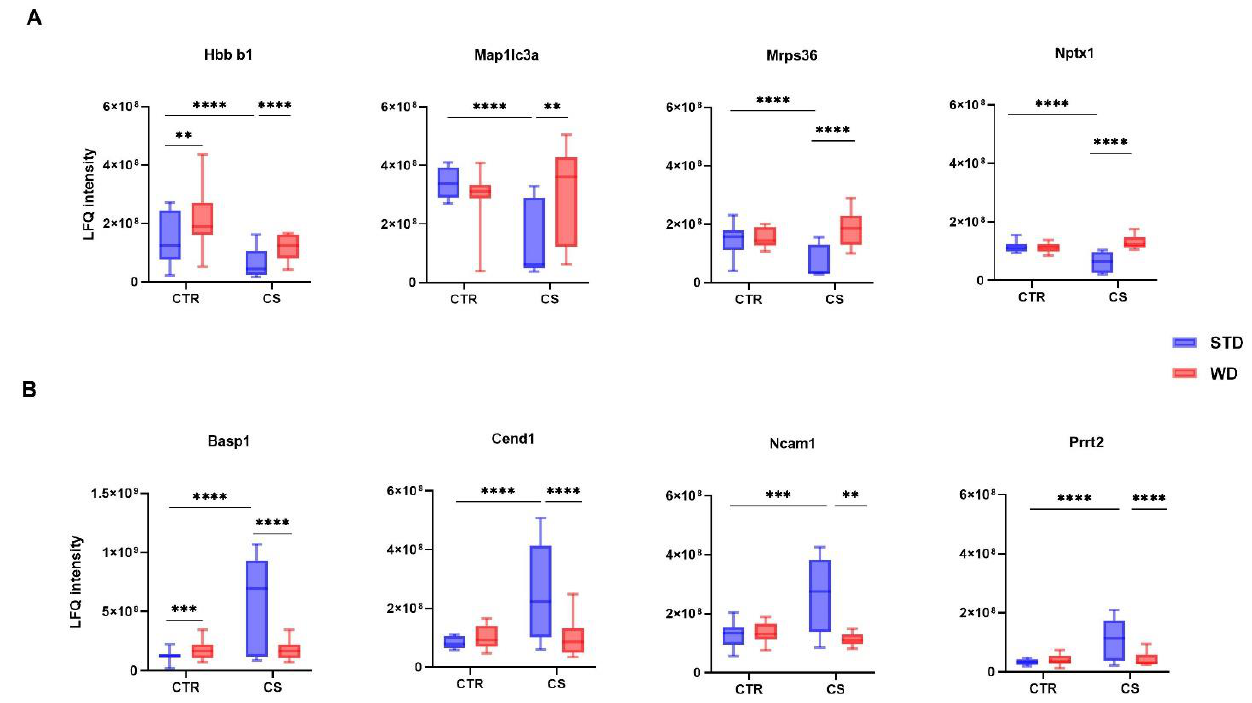
Figure 1. Eight representative proteins showing the most significant changes in the cerebrocortical proteome after exposure to chronic stress and Western diet. The data shown in panels ( A , B ) were collected and analyzed from 4 experimental groups: control rats fed with standard diet (STD) (CTR, n = 12), rats fed with Western diet (WD, n = 12), rats fed with standard diet and subjected to chronic stress (CS, n = 6), rats fed with Western diet and subjected to chronic stress (WD/CS, n = 6). LFQ = label-free quantitation. Hbb b1 (Hemoglobin subunit beta-1), Map1lc3a (Microtubule-associated proteins 1A/1B light chain 3A), Mrps36 (Mitochondrial ribosomal protein S36), Nptx1 (Neuronal pentraxin-1), Basp1 (Brain acid soluble protein 1), Cend1 (Cell cycle exit and neuronal differentiation protein 1), Ncam1 (Neural cell adhesion molecule 1), Prrt2 (Proline-rich transmem- brane protein 2). Data are expressed as median +/ − min. to max. Two-way ANOVA, post hoc test: Significant differences are indicated by ** p < 0.01, *** p < 0.001, **** p <